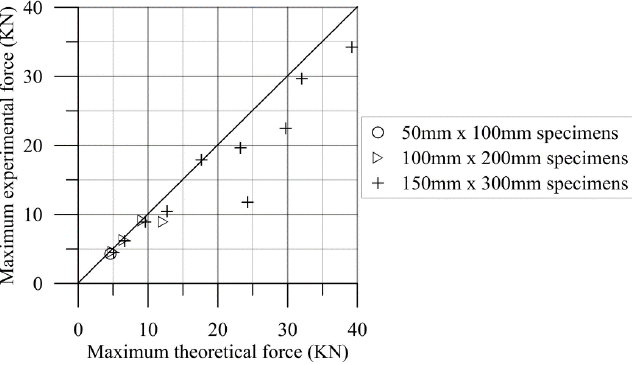
Figure 9. Comparison between experimental maximum force and theoretical maximum